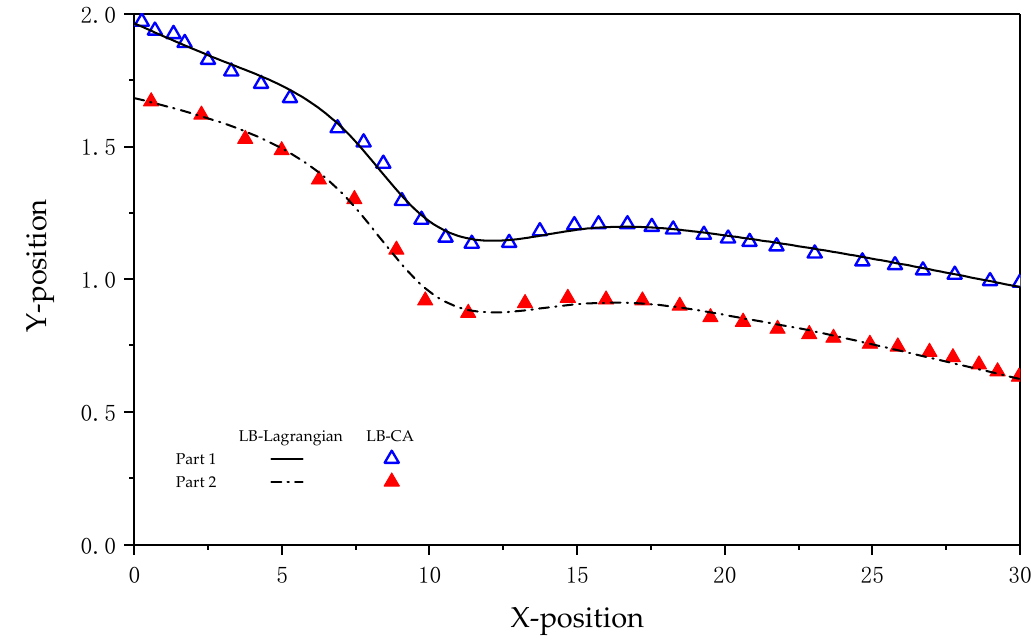
Figure 12. Comparison of particle trajectories between the LB-Lagrangian and LB–CA methods .